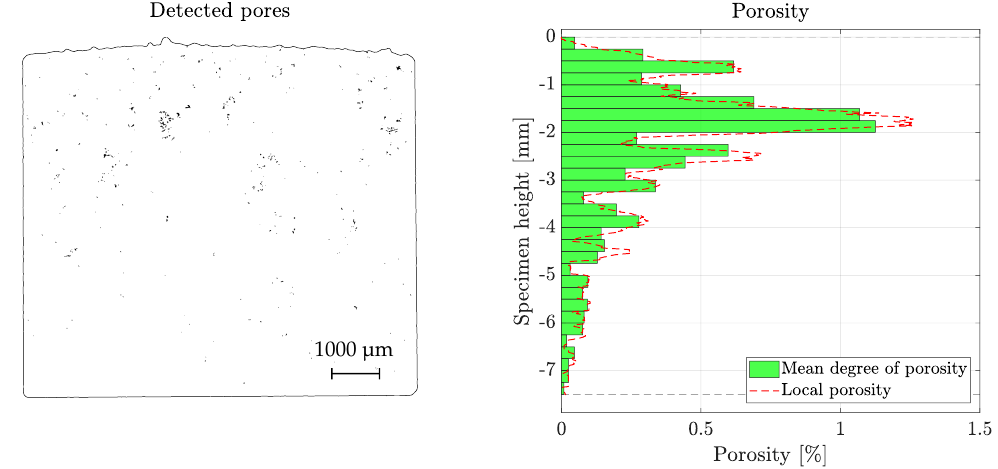
Figure 6. Detected pores and degree of porosity of an exemplary cast surface T6 P1 cross section.